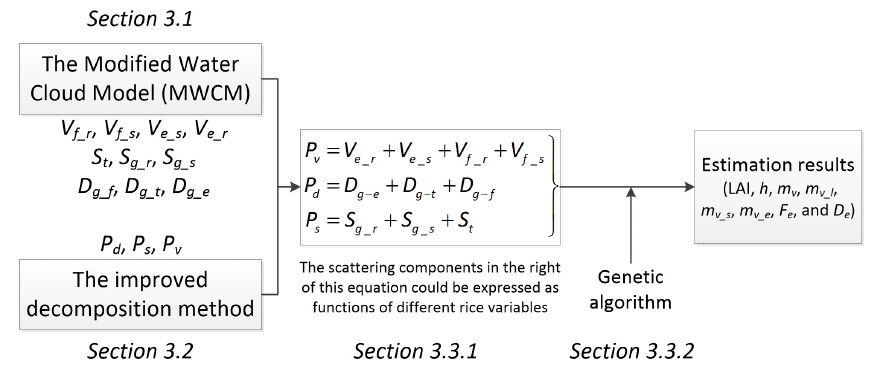
Figure 8. Flow chart for rice variable estimation with the MWCM and improved polarimetric